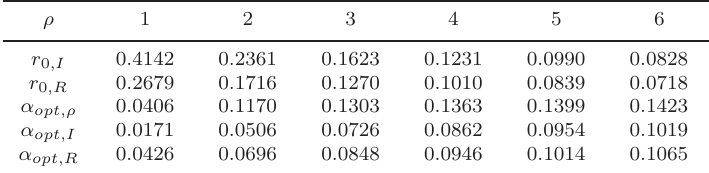
Table 1. Optimal parameters α opt,ρ , α opt,I and α opt,R corresponding to ρ and r 0 . ρ 1 2